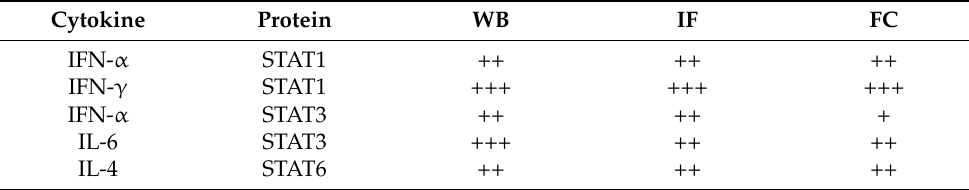
Table 1. Summary of cytokine specific activation patterns in MG63